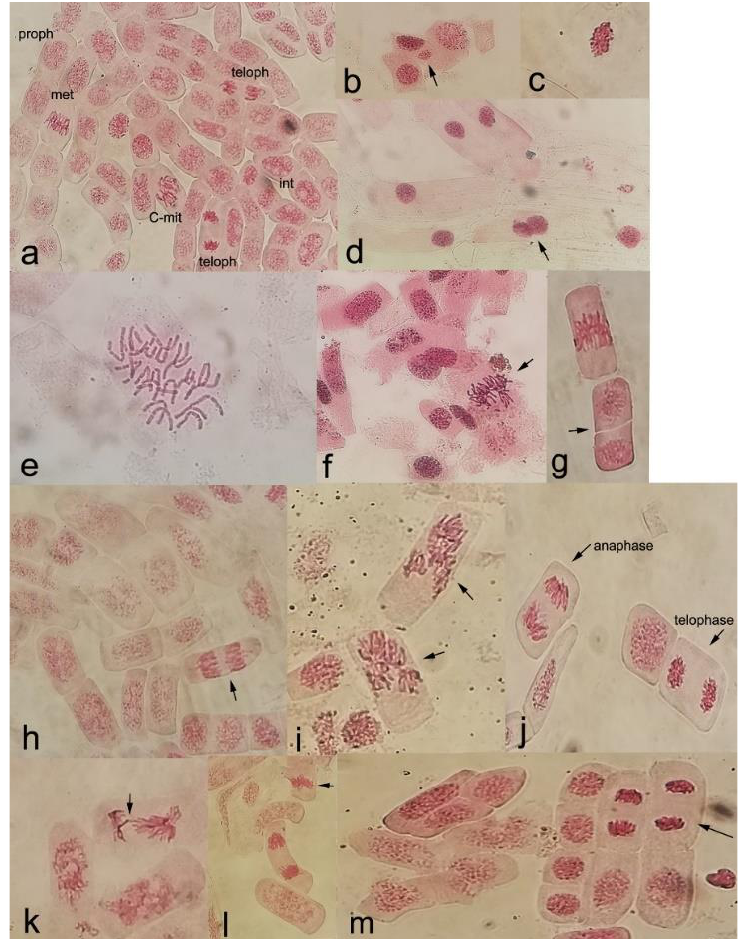
Figure 4. Root meristematic cells of Pinus pinaster Aiton (2n = 2x = 24) stained with 2% aceto-carmine showing: ( a ) — cells in interphase (int), prophase (proph), and metaphase (met), as well as irregular metaphase (C-mitosis) and telophase (teloph) cells; ( b ) — one irregular prophase with one micronucleus (arrow); ( c ) — a sticky prophase; ( d ) — a binucleate prophase (arrow); ( e ) — C-mitosis; ( f ) — metaphase with disturbance in chromosomal orientation, and laggard chromosomes (arrow); ( g ) — one metaphase (upper cell) and one irregular telophase with disturbed orientation (arrow); ( h ) — anaphase cell with laggard chromosomes (arrow); ( i ) — multipolar anaphases; ( j ) — one anaphase with chromosomal disturbance and one normal telophase; ( k ) — anaphase with one chromatin bridge (arrow); ( l ) — unipolar anaphase (arrow) and one sticky telophase; ( m ) – two sticky telophase cells (arrow).